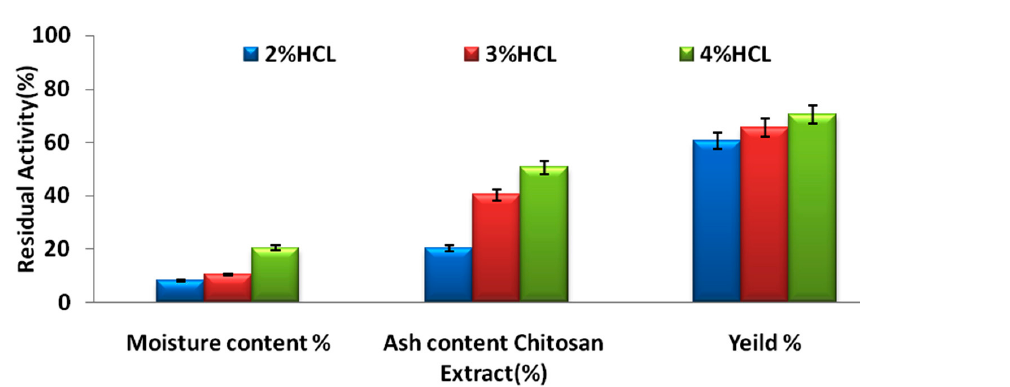
Fig.1. The residual activity of Chitosan extract with various concentration of hydrochloric